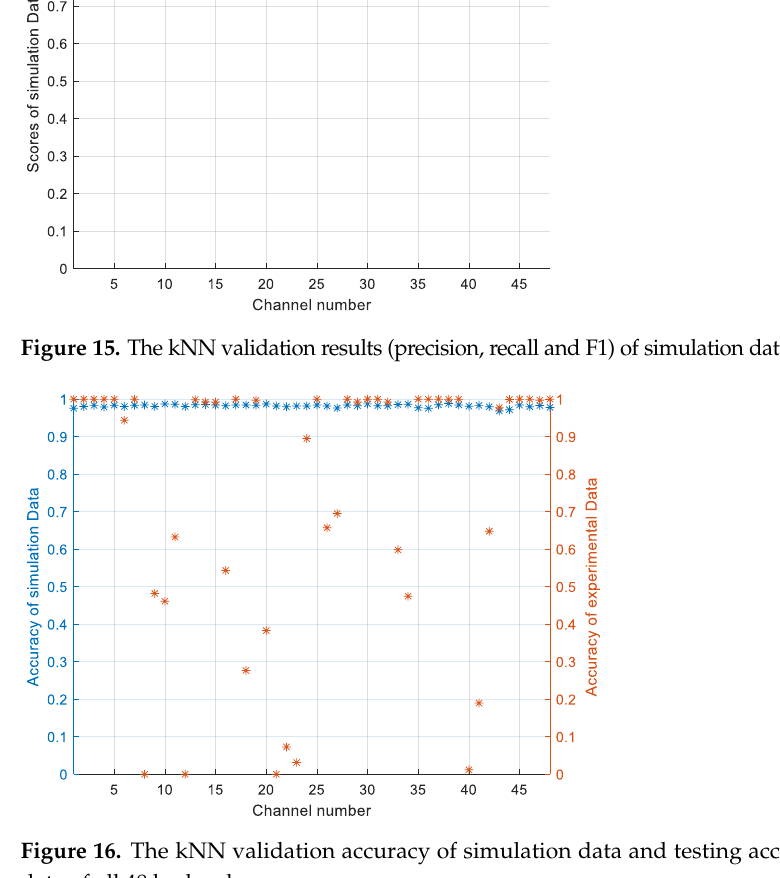
Figure 16. The kNN validation accuracy of simulation data and testing accuracy of experimental data of all 48 hydrophones.